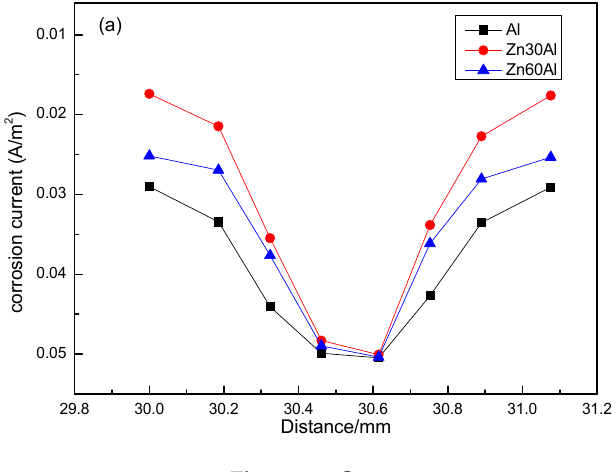
Figure 11. Cont. Figure 11. Cont.